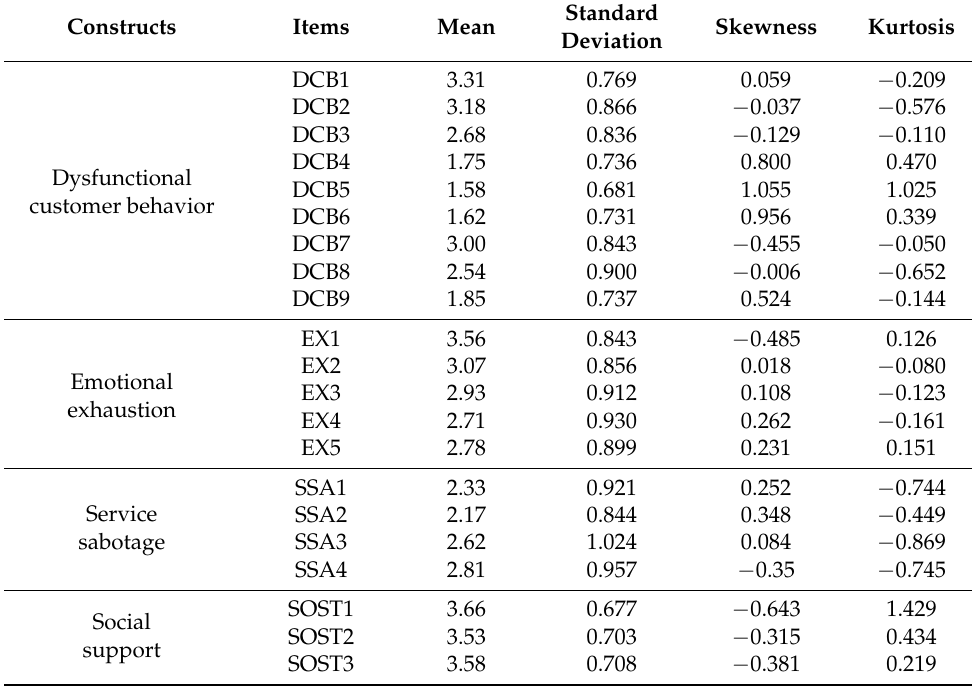
Table A1. Normal distribution